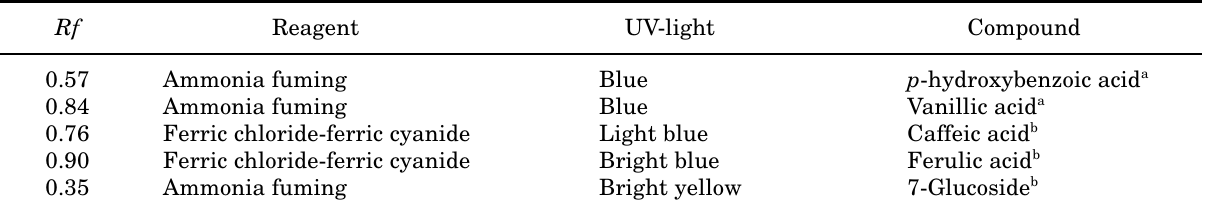
Table 5. Rf -values of the phenolic principle(s) in the ether fraction of aqueous root extract of Lantana camara and their reaction to a developing reagent and UV